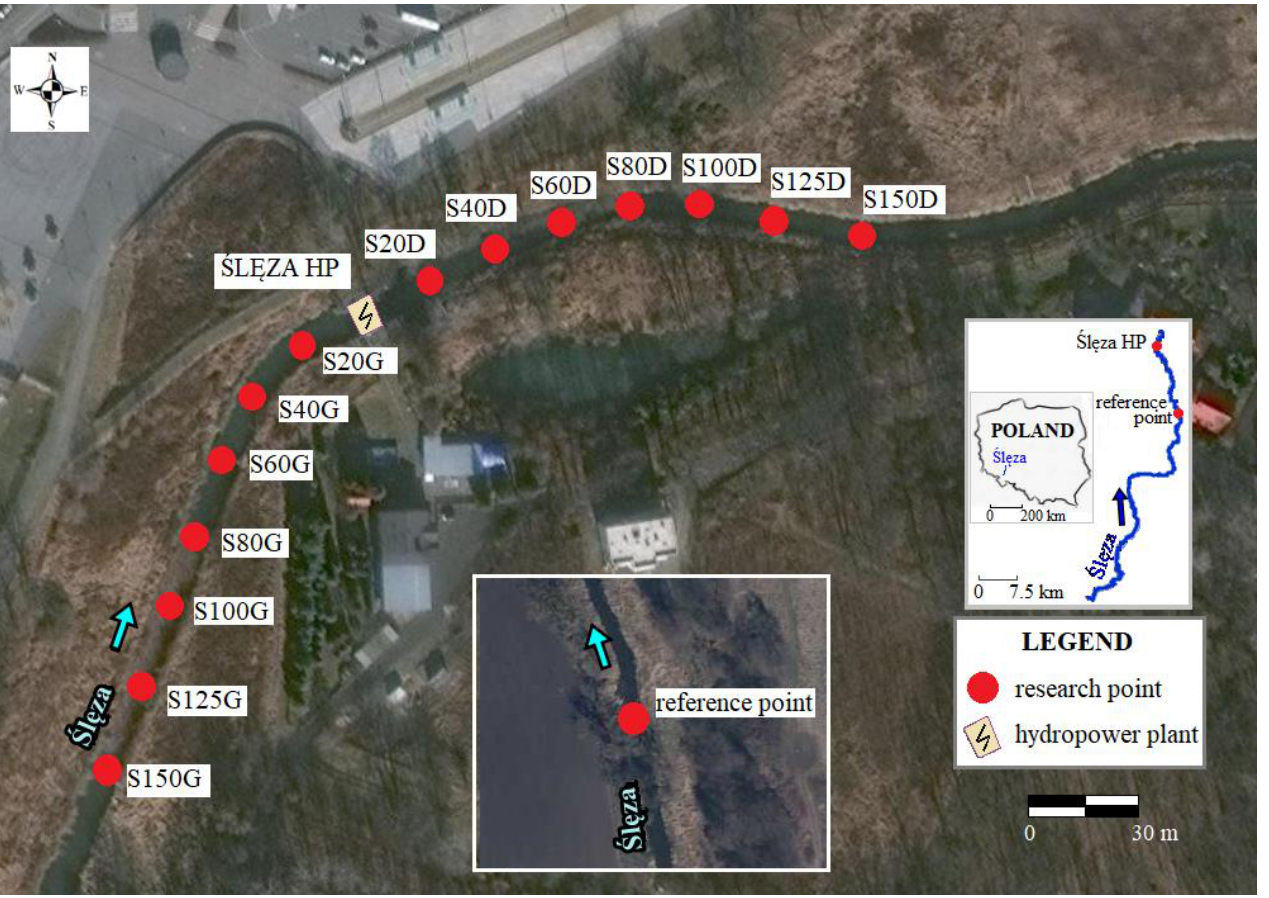
Figure 1. Sediment sampling points of the hydropower plant in Wrocław on the Ślęza River.